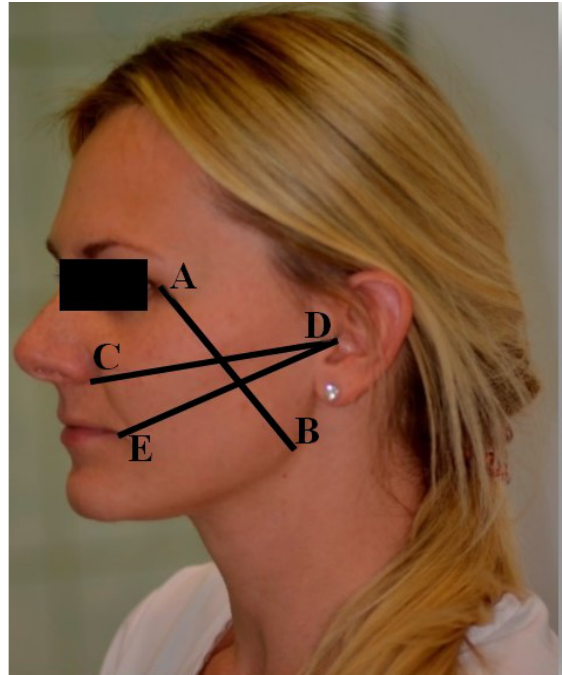
Figure 1. Measurement lines and points on the face .